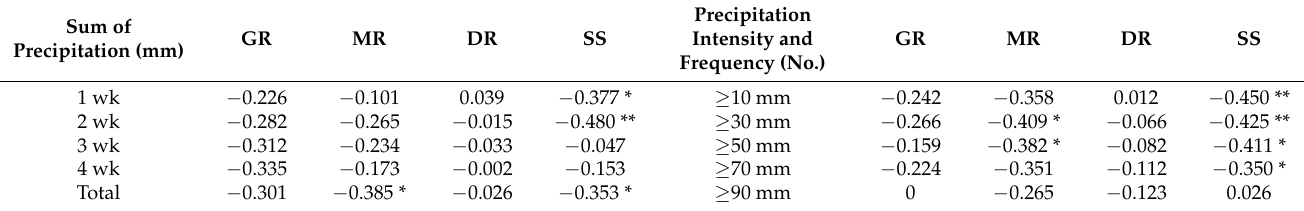
Table 6. The correlation coefficients between precipitation pattern and Community Dynamic Index (CDI) in four central western major streams of the Korean Peninsula from 2013 to 2015 (GR: Geumgang River, MR: Mangyeonggang River, DR: Dongjingang River, SS: Sapgyocheon